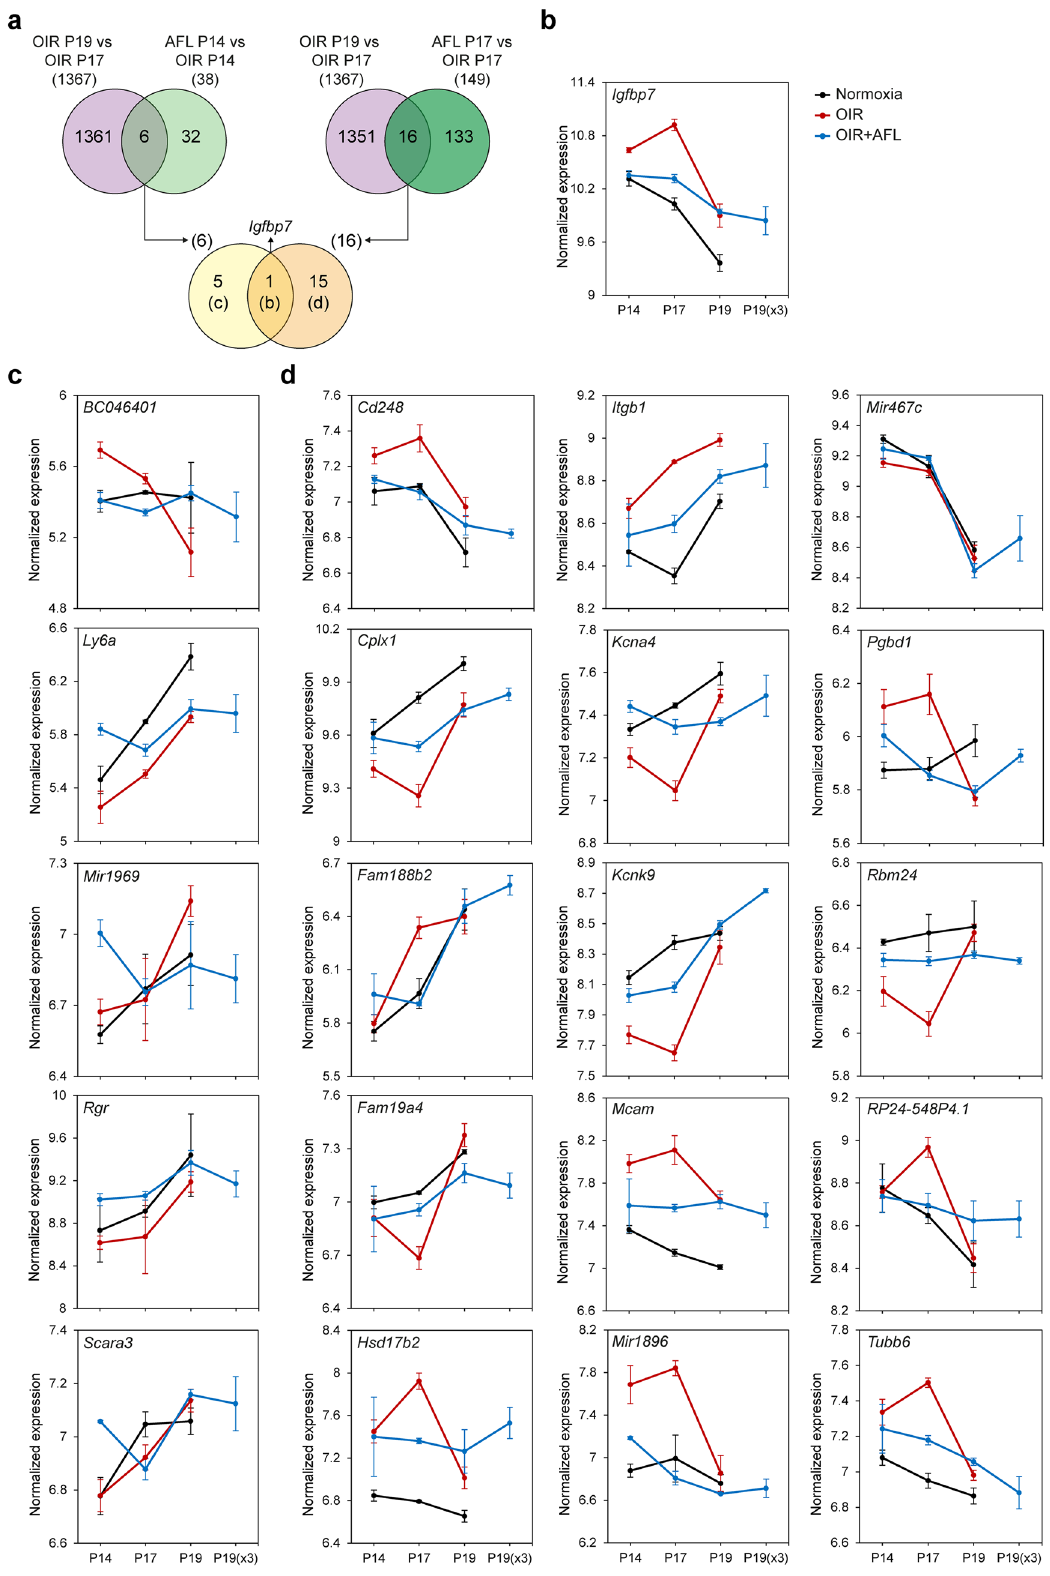
Figure 5. Genes differentially expressed both during the post-P17 recovery phase of the OIR protocol and in response to AFL administration either at P14 or at P17. ( a ) Venn diagrams depicting the overlap in differentially regulated genes identified from P17 to P19 in OIR retinas and either in P14 (left) or P17 (right) OIR retinas after AFL administration. The two sets of genes overlapping in these comparisons were compared to each other, with only one common gene identified (middle). ( b–d ) Normalized expression levels of the genes identified in the overlaps of the Venn diagrams in ( a ) at each time-point (P14, P17, P19) and condition (Normoxia, OIR, OIR + AFL). The additional P19(× 3) time-point refers to retinas of OIR animals that received 3 doses of AFL and were examined at P19. Error bars in ( b–d ) depict ± 1